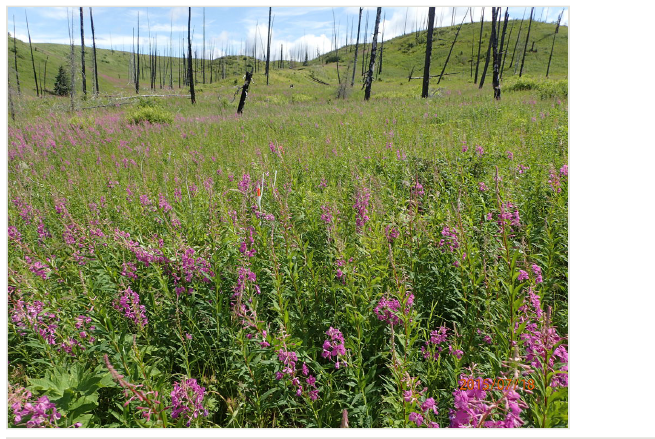
Study site 73F (60.1055°N, 151.1806°W), a site characteristic of our study area dominated